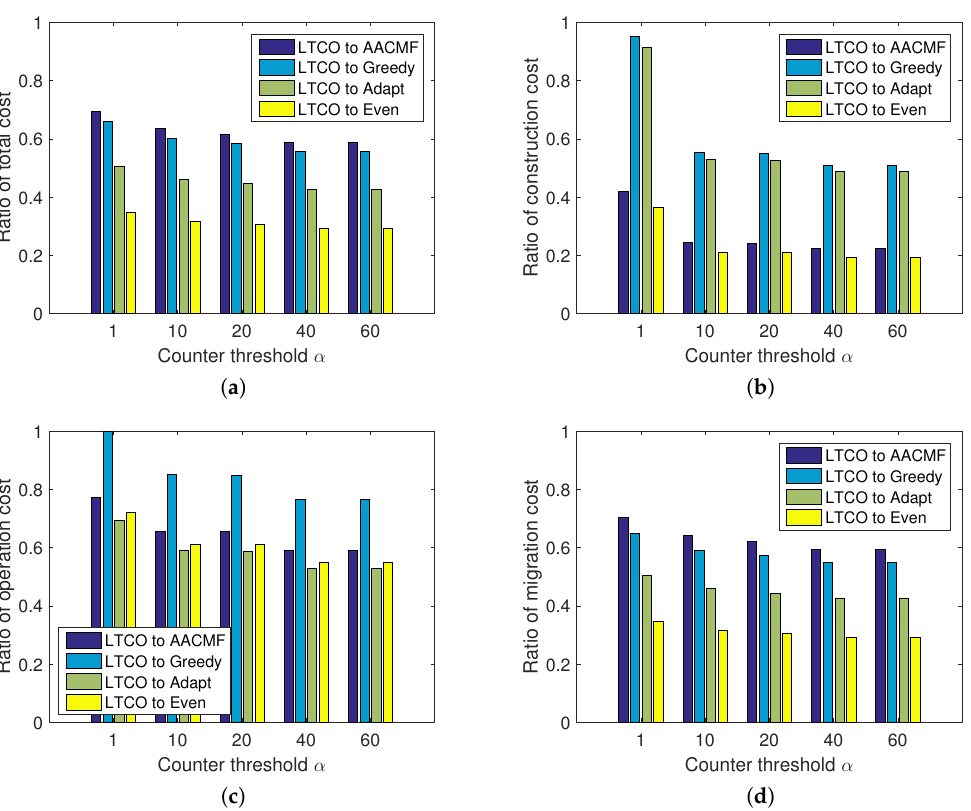
Figure 7. Impact of varied counter threshold α for randomly generated mobility traces.